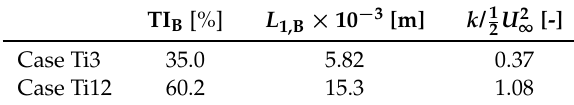
Table 3. Characteristics of the different boxes of synthetic turbulence used as inflow for the LES.